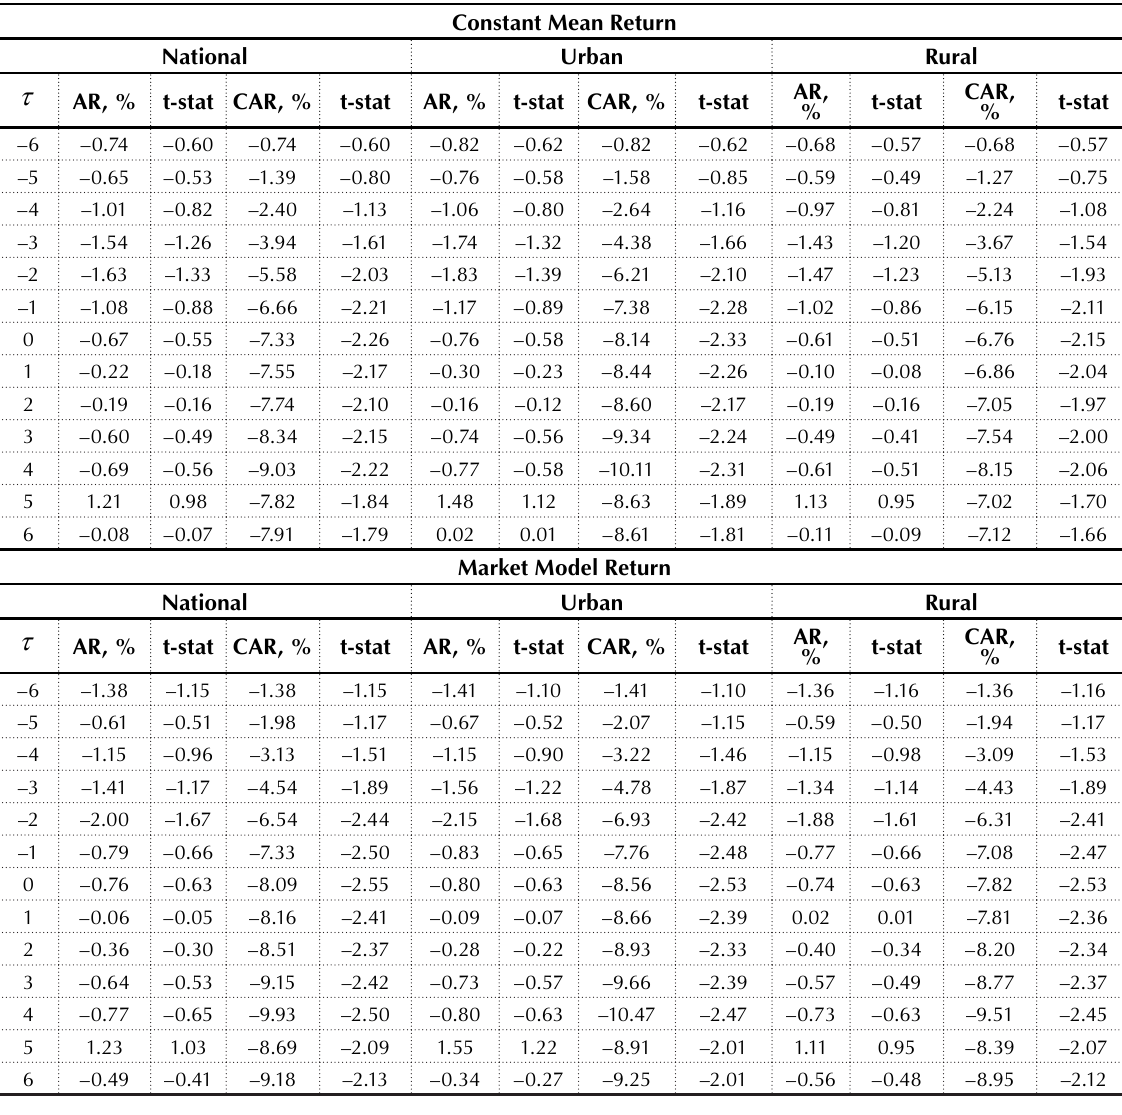
Table 2. Effect of the modification to personal income tax law on housing